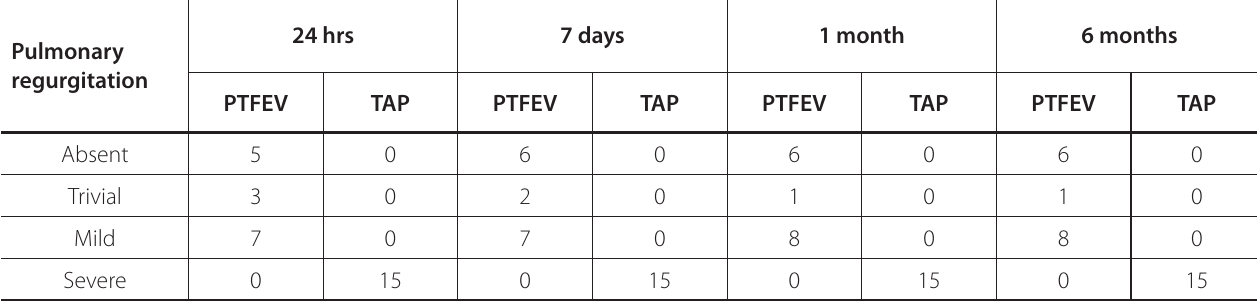
Table 6 . Progression of pulmonary